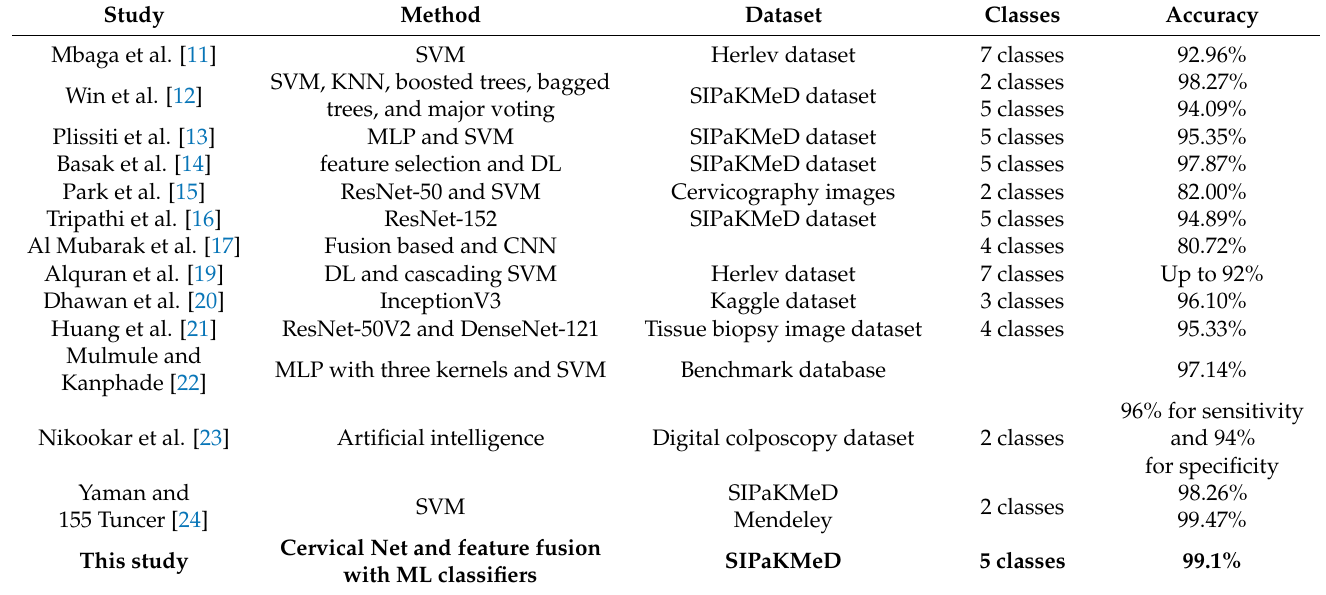
Table 4. Comparison of the proposed method with previous